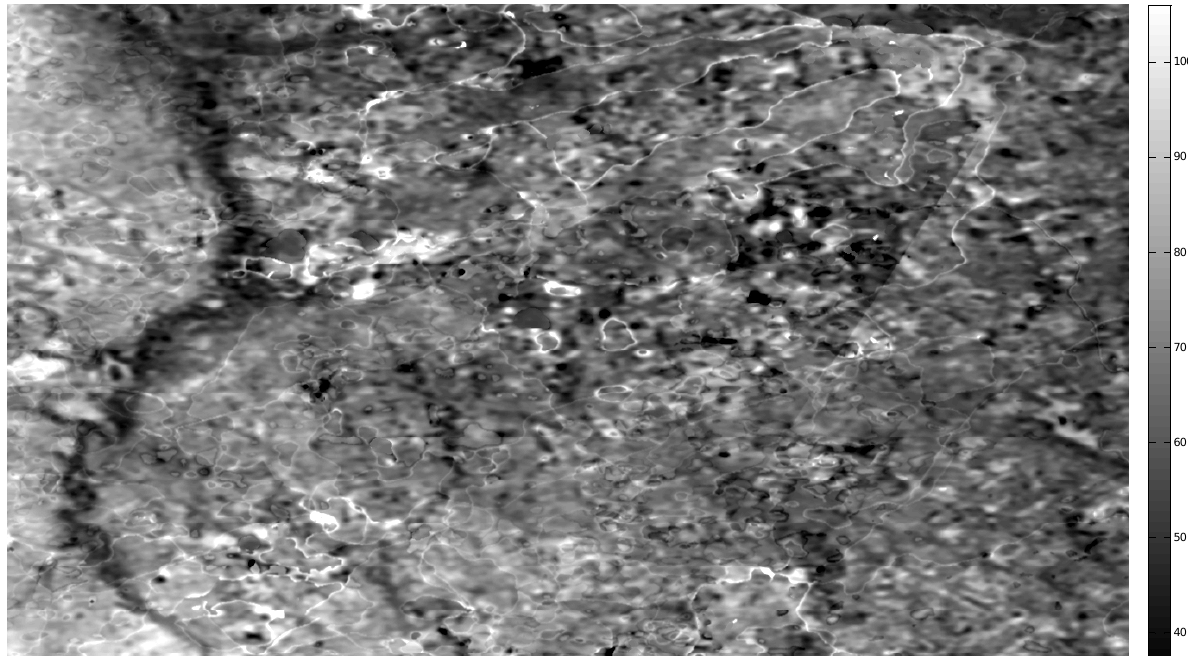
Figure 8. ASTER GDEM sample data corresponding to an area of 24 km × 39